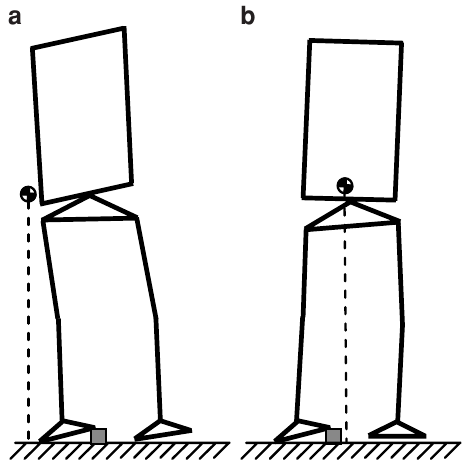
Figure 1 (a) The lost of the balance, (b) the balance is